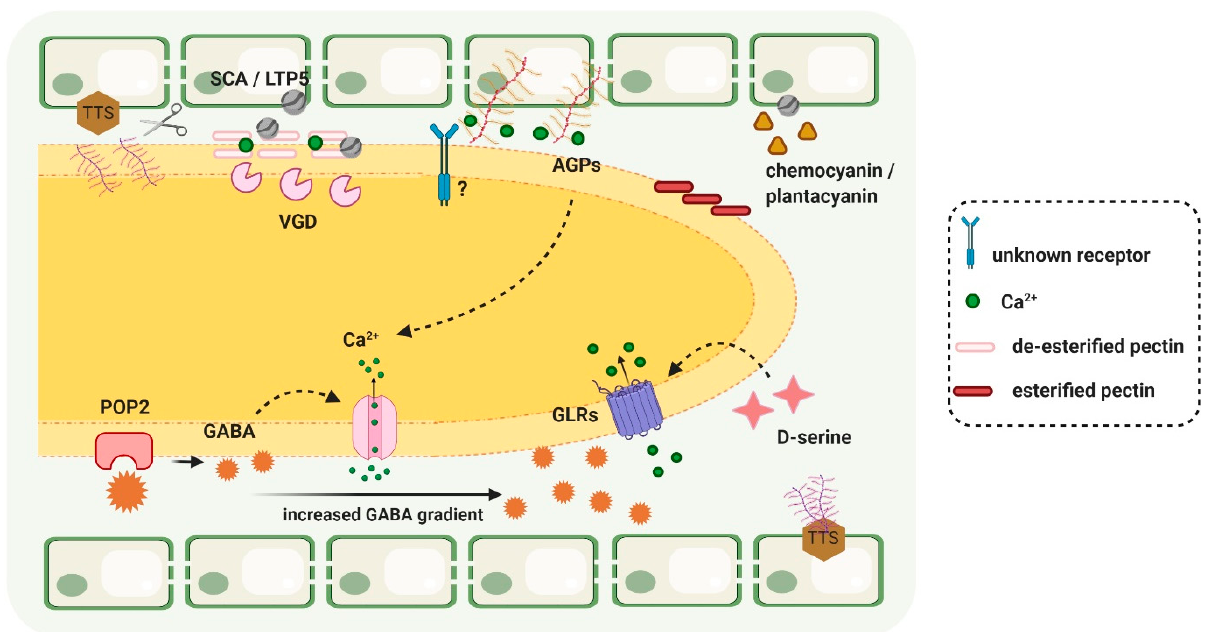
Figure 3. Main signaling molecules involved in the communication between pollen tube and transmitting tract during its growth in this tissue, towards the ovule. This image aims to focus mainly on the transmitting-tract-secreted signals, rather than on the signals generated by the pollen tube, well described in many reviews. TTS (transmitting-tissue-specific) is shown at the surface of the TT cells either still intact or being deglycosylated (scissors) by the growing PT. The glycosylated TTS is decreased after the arrival of the PTs in the TT, thereby establishing a gradient of increasing TTS glycosylation from the top to the bottom of the style. AGPs (arabinogalactan proteins) are also present in the TT cells and ECM and are thought to play essential roles in PT growth, by some signaling pathway which remains to be unraveled. AGPs are represented by the branched glycans acting as Ca 2+ reservoirs (green dots), which are probably involved in Ca 2+ signaling pathways in the PT. LTP (lipid transfer protein) represents the SCA, stylar cysteine-rich adhesion molecule, secreted by the TT cells, forming an adhesive matrix with pectins between the PT and the TT surface. Chemocyanin is also shown, which has a chemotropic guidance effect on PTs by acting together with SCA. VGD1 (VANGUARD1) is a pectin methylesterase (PME) from the PT, acting on pectin demethyesterification and leading to TT cell wall loosening to facilitate PT growth, possibly by coordinated action with endopolygalacturonases. A GABA ( γ -amino butyric acid) gradient created by male POP2 (POLLEN ON PISTIL 2), a GABA transaminase, is thought to provide cues for PT growth along the TT. Besides this, GABA may modulate Ca 2+ channels from the PT, influencing the dynamic extracellular and intracellular Ca 2+ gradient essential for PT growth along the pistil tissues. Also involved in Ca 2+ gradient changes is D-serine from the pistil tissues, which induces Ca 2+ permeable GLRs (glutamate receptor-like channels) at the PT tip. Created with BioRender.com (accessed on 25 February